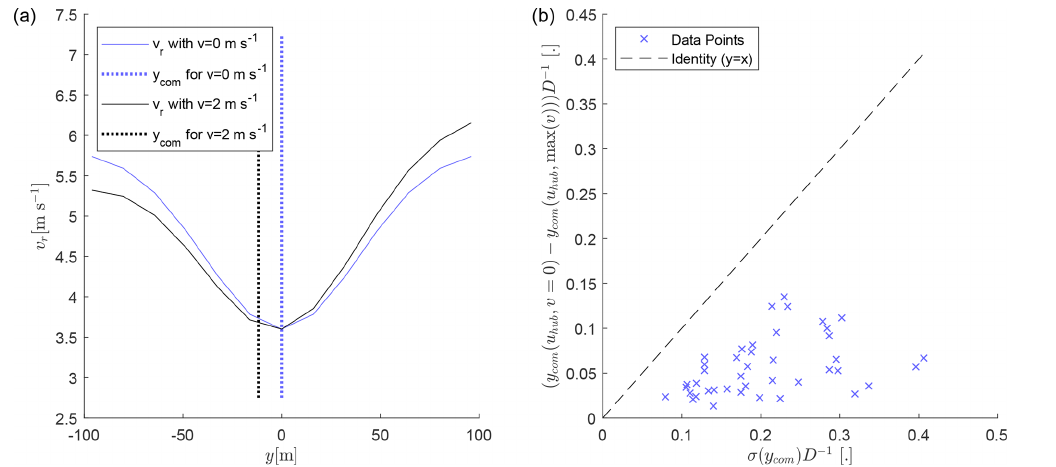
Figure A1. The error of the wake centre position resulting from the influence of the lateral velocity component. Explanations are in the text of Appendix A.